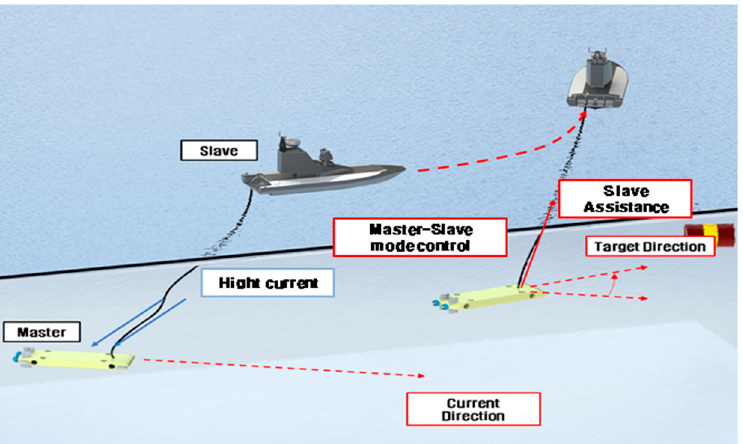
Figure 10. TUP operation sequence.